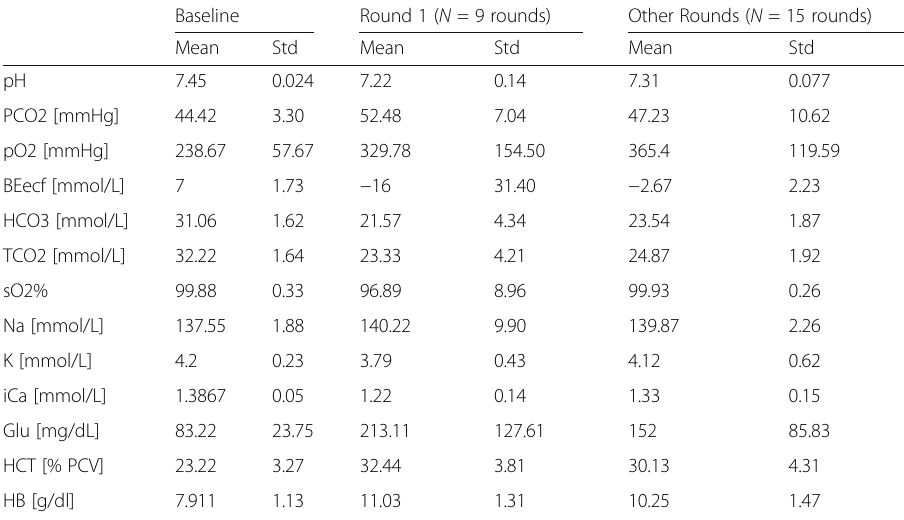
Table 4 Results of blood chemistries from the 9 animals that received iCa in cohort 3 Baseline Round 1 ( N = 9 rounds)